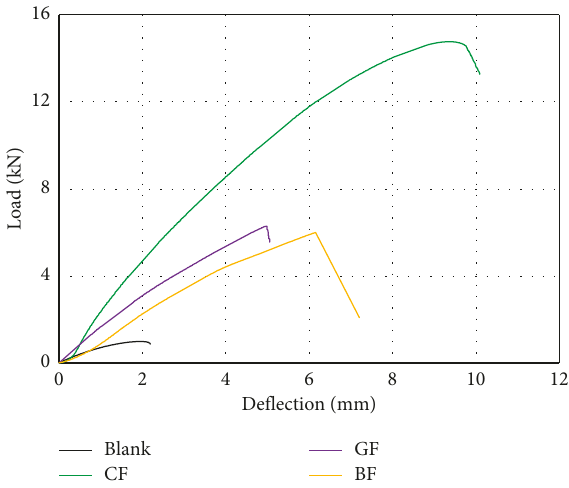
Figure 13: Load-deflection curves at 15 °